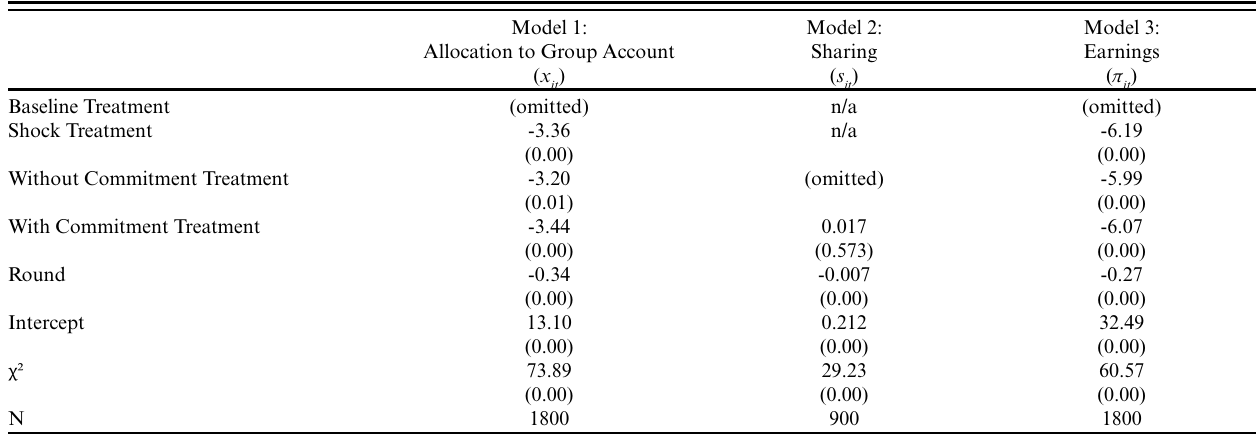
Table 4 . Conditional estimates of individual-level treatment